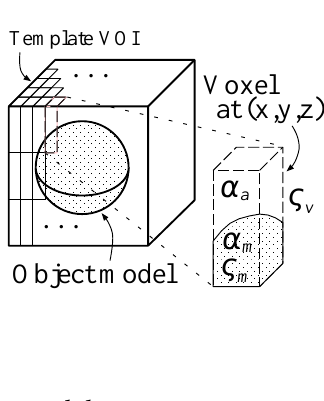
Figure 4. Production of template